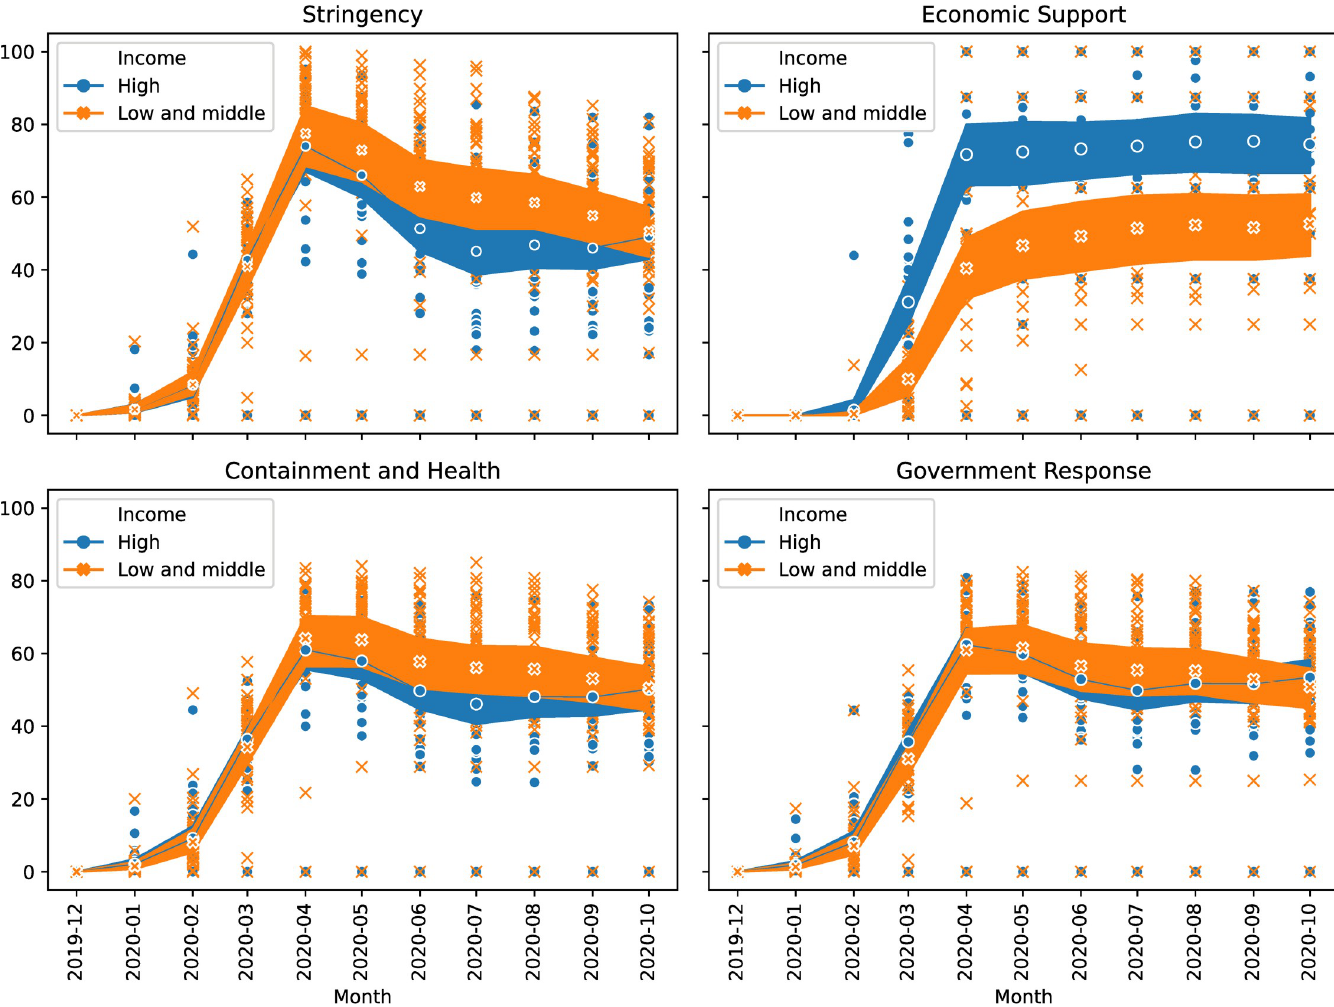
Fig 1. Evolution of the four COVID-19 policy indicators between December 2019 and October 2020 by income level for our sample of exporting countries. Source: own elaboration from [63]. Note: each point represents a country, and the concentration of countries with similar values produces darker areas. Additionally, the mean and 95% confidence bands are